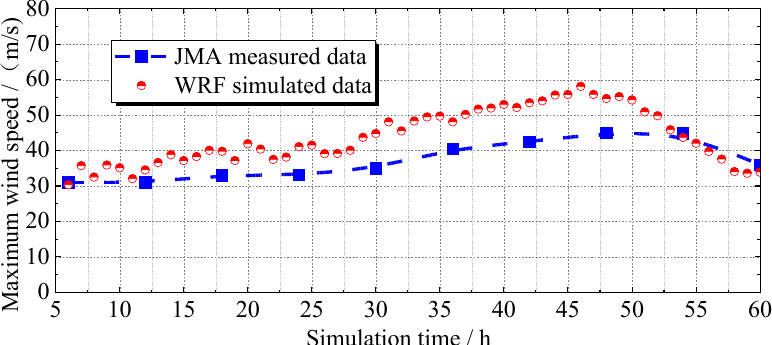
Figure 4. Schematic diagram of WRF simulation.